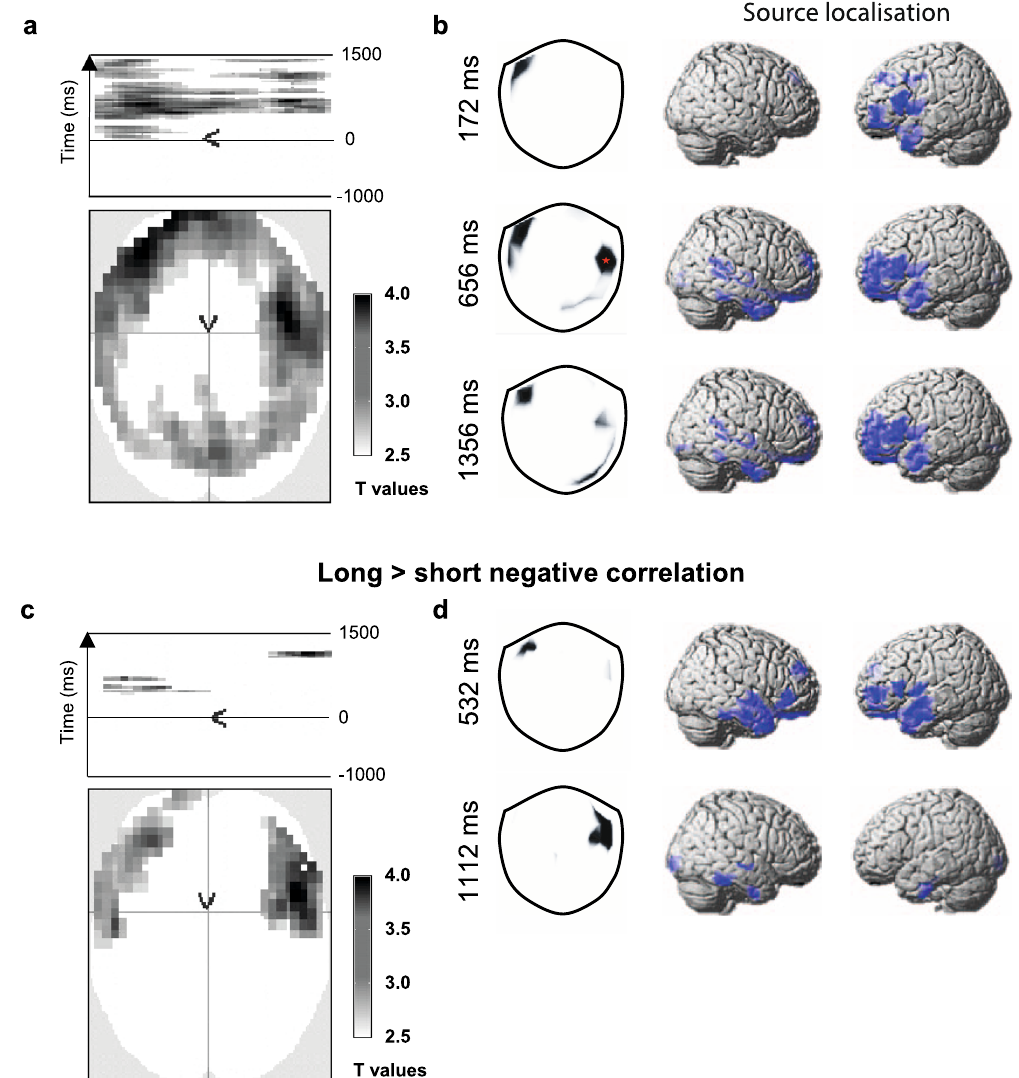
Figure 3. Trial entropy correlations with MEG. ( a ) The significant negative correlations between TE and planar gradiometer data, averaged across all TE windows in sensor-time space (voxel threshold: p < 0.001, t > 3.17 with FWE cluster thresholded at p < 0.05). The scalp plot shows the sensor space clusters collapsed across time and the figure above shows the x plane of sensor space against time. Note that all significant correlations were observed after the response time at t = 0 ms. ( b ) The t-maps (left) show those scalp locations at which negative correlations were above threshold at the peak time point of each cluster. The location of peak overall group response across the whole of scalp-time space is indicated by a red star. We visualised the location of the neural sources (right) within a 20 ms time window around each of these time-points (p < 0.01, t > 2.36). At t = 172 ms, source peaks were observed in the left inferior frontal gyrus, and anterior middle frontal gyrus (Neuromorphometrics atlas). Similar peak locations were observed for t = 656 ms and t = 1356 ms in left anterior middle frontal gyrus, right superior temporal gyrus and left temporal pole. ( c ) Clusters in sensor-time space with significantly greater negative correlations for longer trial windows (thresholding as panel a). ( d ) The t-maps (left) show the scalp location of the significant differences between window lengths at the peak time point for each cluster. For the t = 532 ms peak, the sources were localised to the left anterior middle frontal gyrus and bilateral superior temporal gyrus (thresholding as panel b). For the t = 1112 ms peak, the largest cluster was localised to the right inferior temporal